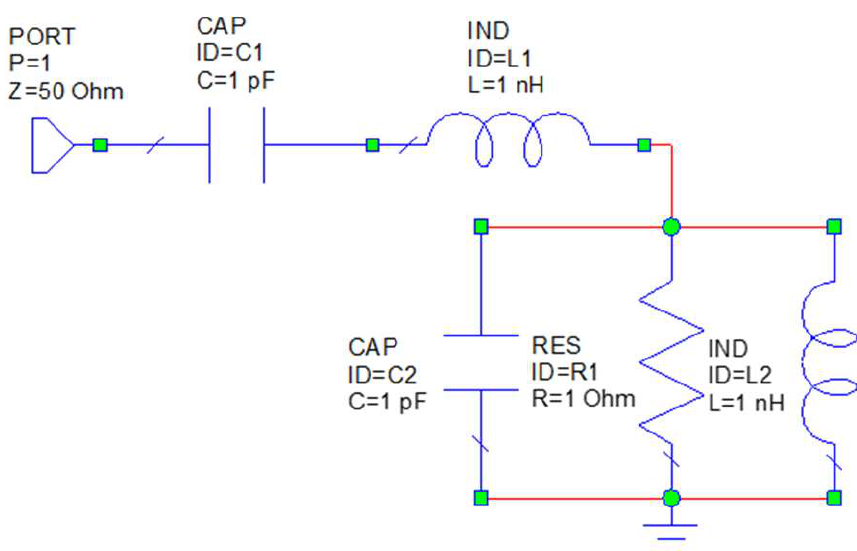
Figure 7. Equivalent circuit of the typical dipole with default values of lumped elements.